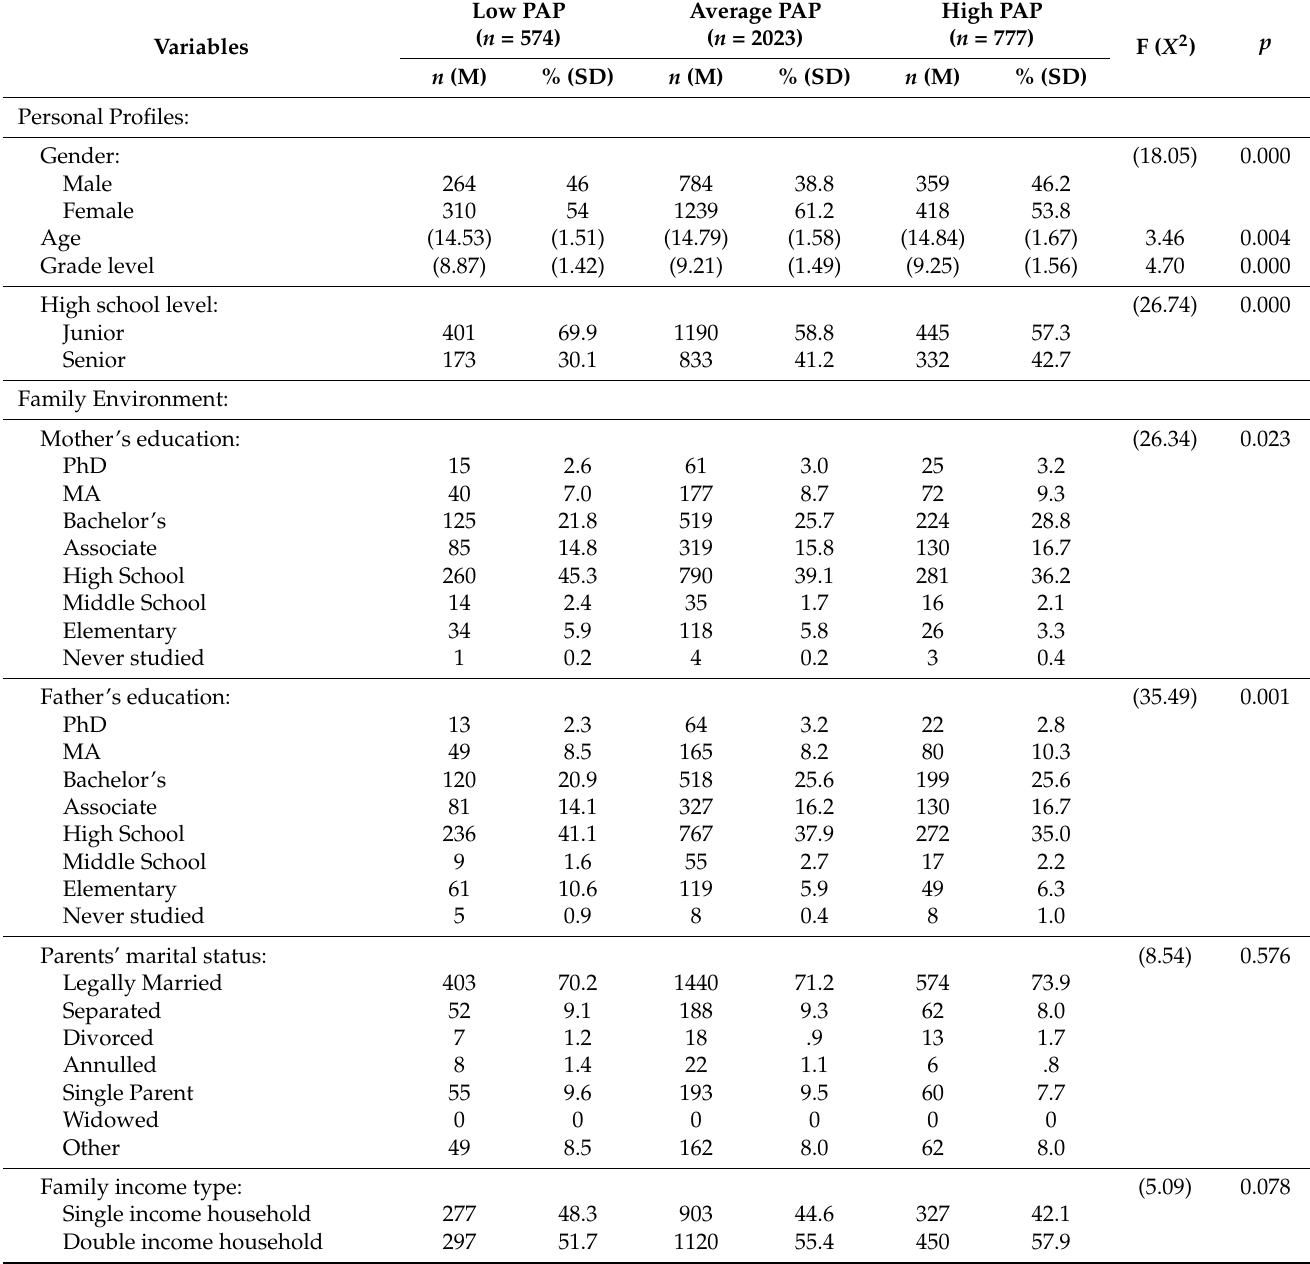
Table 3. Differences in personal profiles, family environment, smartphone usage pattern, smartphone addiction, and nomophobia across perceived academic performance